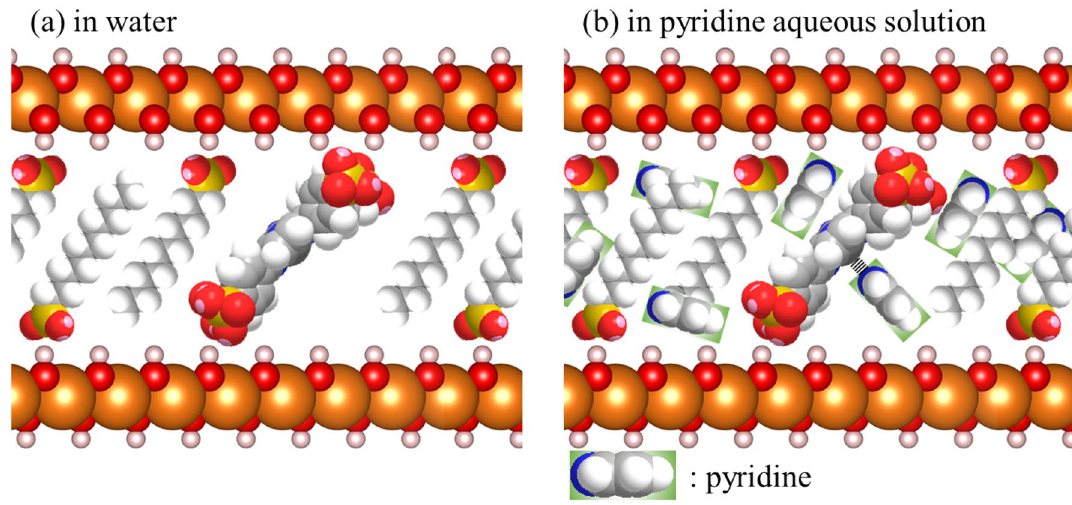
Figure 5. Schematic structural model of the ZnTPPS/C10S/LDH materials in the (a) absence and (b) presence of pyridine in an aqueous solution.